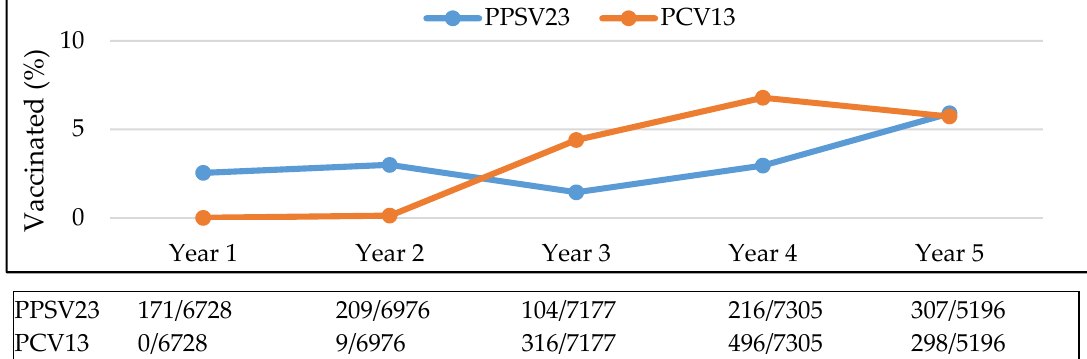
208/5196 Figure 3. Cumulative proportion of sample population vaccinated. Abbreviations used: CDC: Centers for Disease Control and Prevention. 1119/5196 Figure 4. Percentage of population vaccinated, by vaccine. Abbreviations used: PPSV23: pneumococcal polysaccharide vaccine; PCV13: pneumococcal conjugate vaccine.